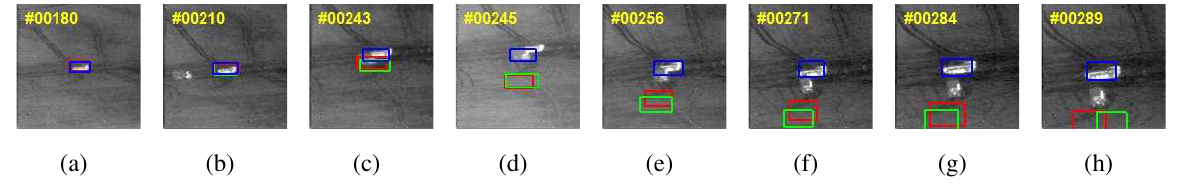
Figure 1. Tracking results of three trackers for sequence LW-16-08.